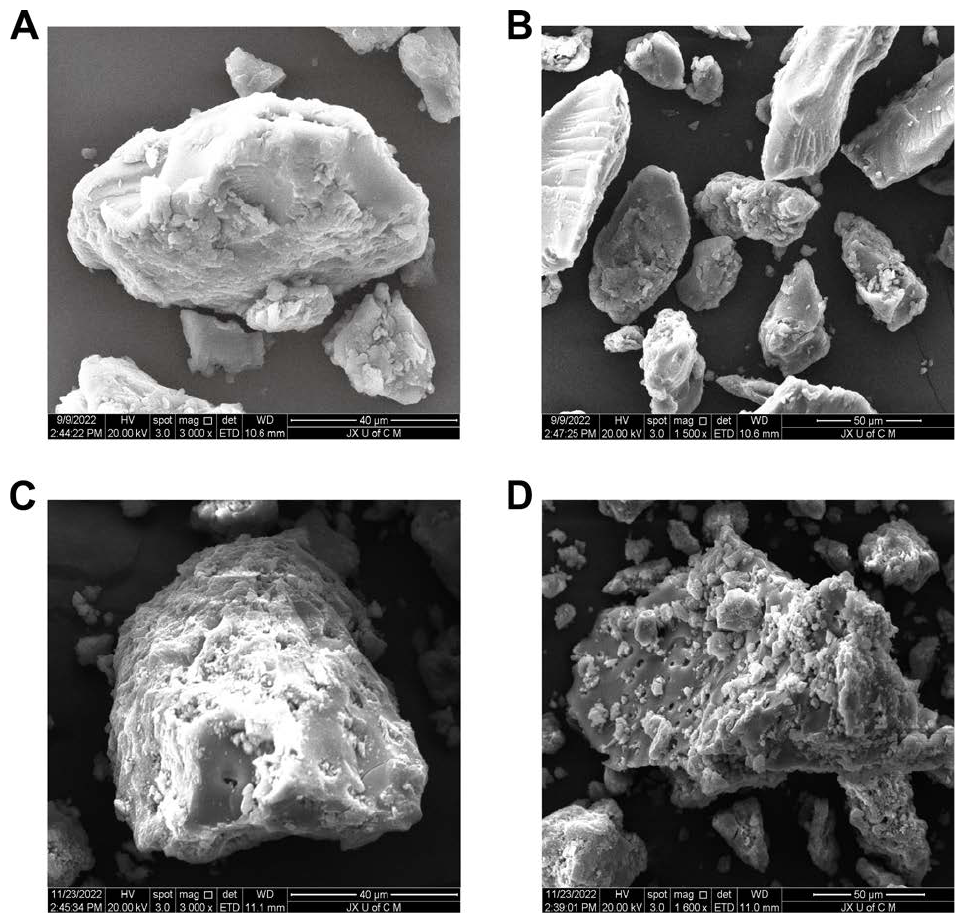
Figure 2. SEM micrographs of unloaded hydrogels at 3000× ( A ) and 1500× ( B ), and drug-loaded hydrogels at 3000× ( C ) and 1600× ( D ).